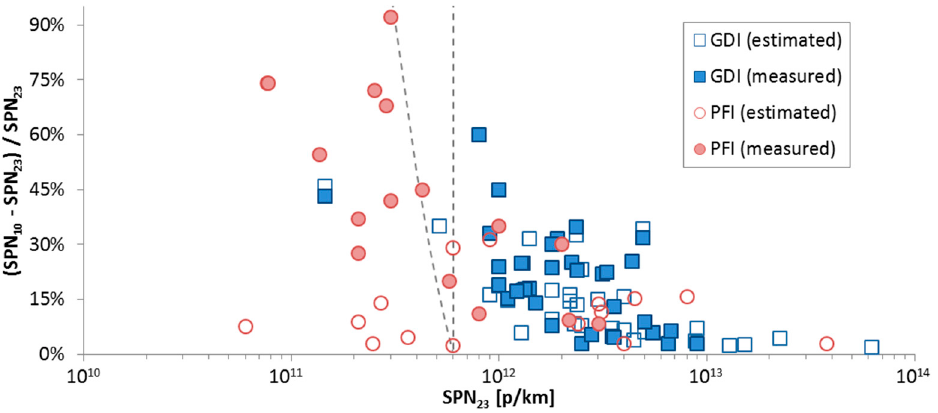
Figure 7. Additional particles below 23 nm as a function of the emission levels of particles > 23 nm. Measured: Based on 23 nm and 10 nm condensation particle counters (CPCs) downstream of a thermal pretreatment unit. Estimated: Based on solid particle size distributions (Figure 3). No corrections for particle losses. Dashed lines show the 6 × 10 11 p / km limit for 23 nm (vertical) and 10 nm